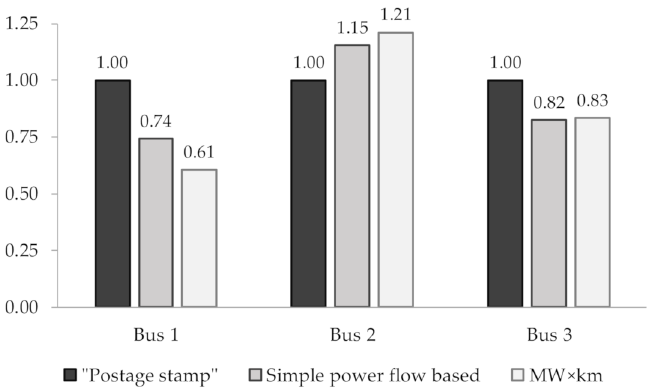
Figure 8. Relative rates of fixed transmission charges for consumers connected to the two-sided supplied